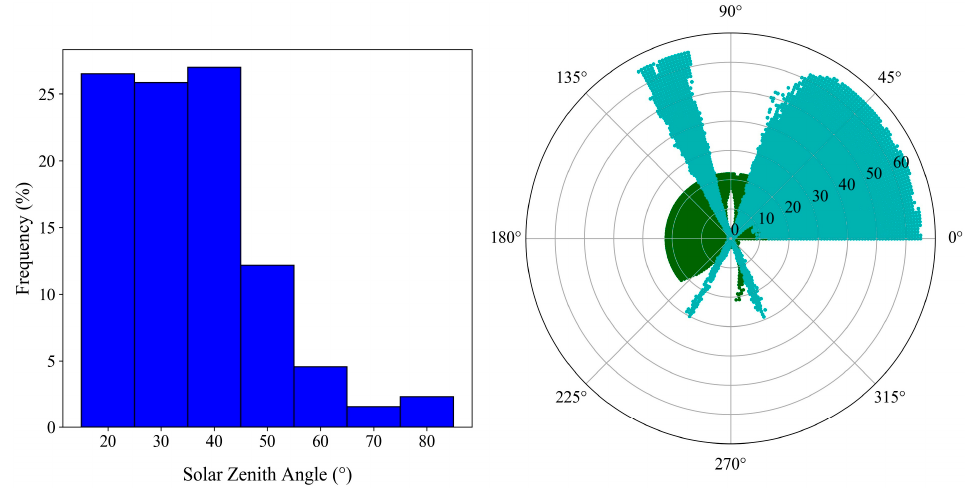
Figure 2. Angular sampling of solar zenith angle (left panel), Moderate Resolution Imaging Spectroradiometer (MODIS) (cyan dot in right panel), and Advanced Along-Track Scanning Radiometer (AATSR) (green dot in right panel). In the right panel, the polar radius is the viewing zenith angle (VZA) and the polar angle is the relative azimuth angle (RAA).